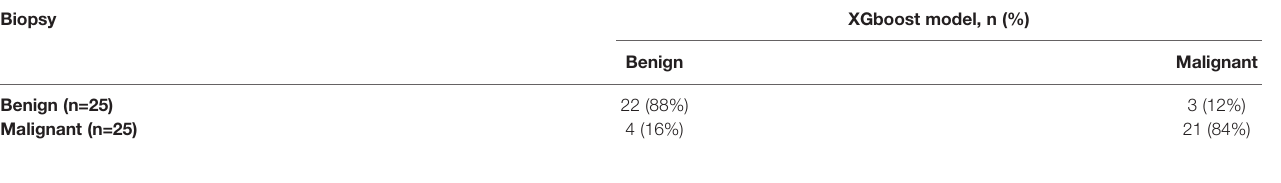
TABLE 5 | Validation of a XGboost model for predicting BC in MRI BiRADS 4.